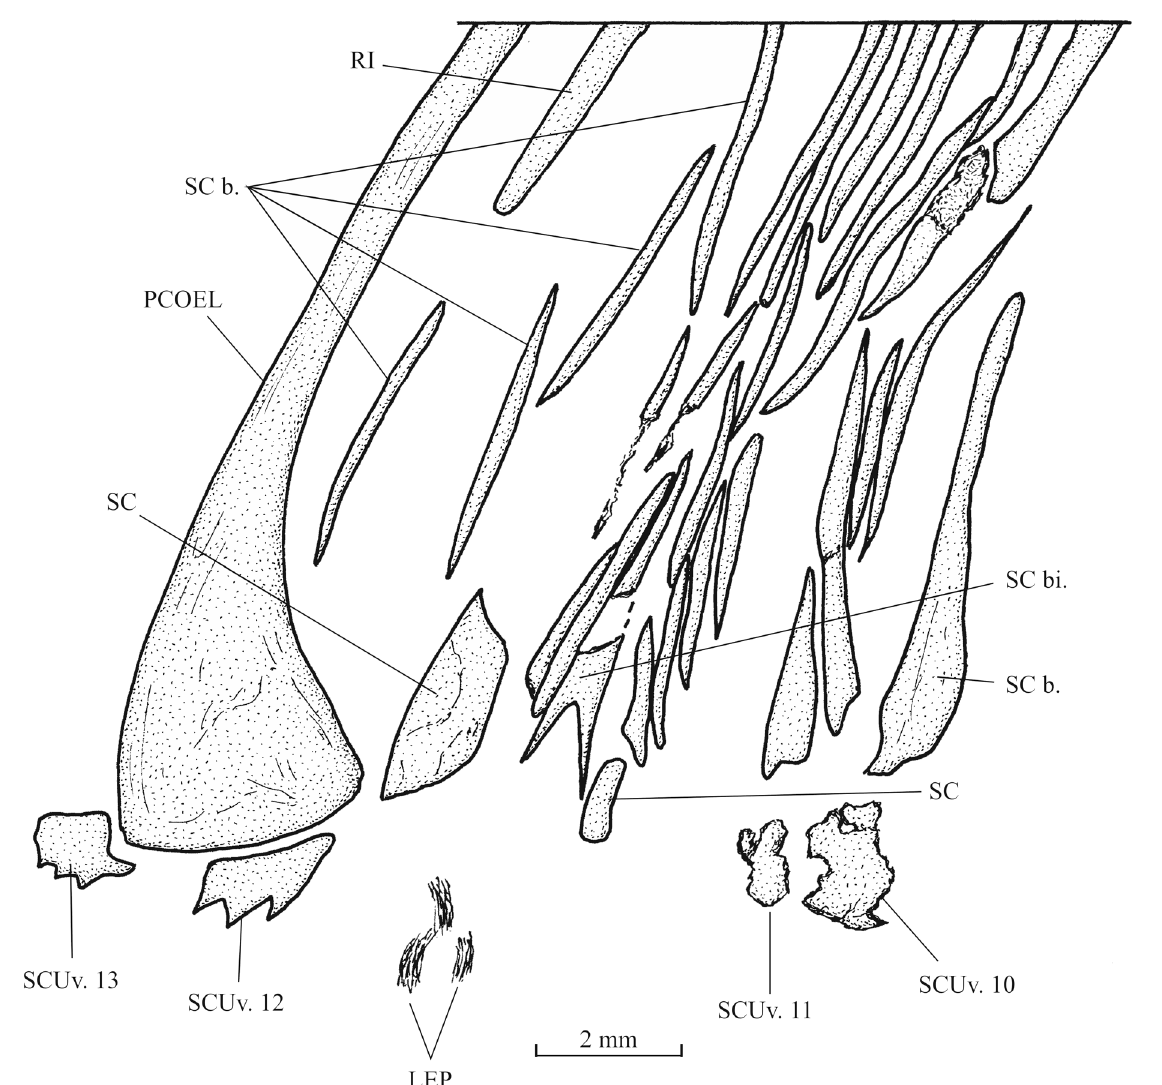
Fig. 11. Libanopycnodus wenzi gen. et sp. nov., holotype, cloacal region (CLC